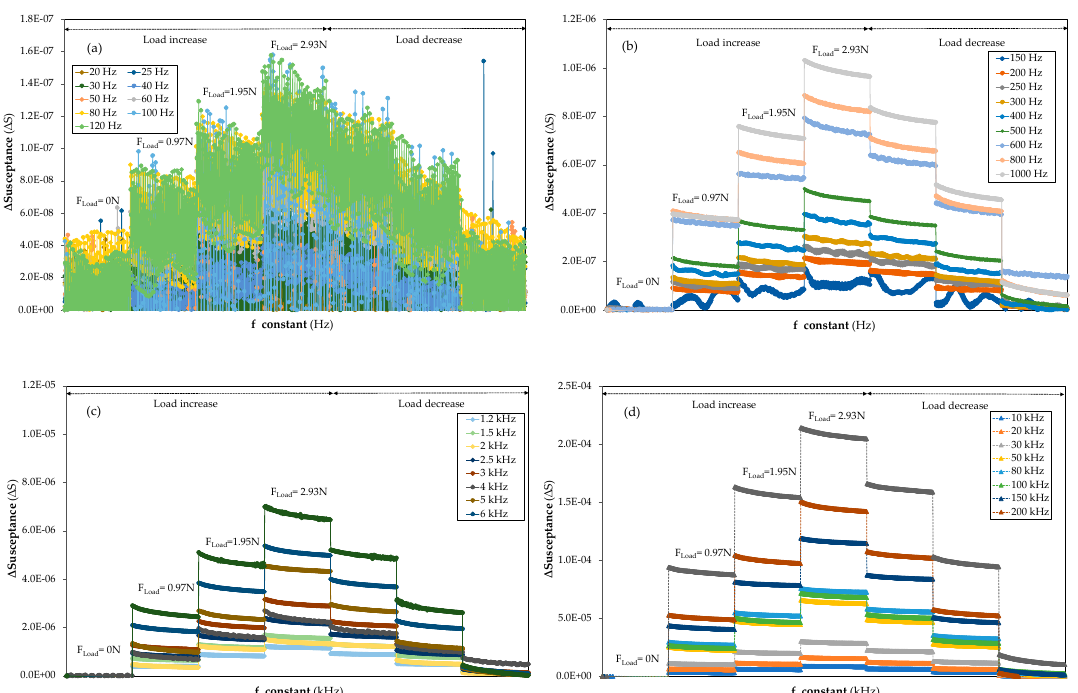
Figure 4. Loading and unloading e ff ect (from F = 0N to 3N) on ∆ S measured on the time domain signal at a constant frequency for a smart structure manufactured in 3 mm thick aluminium: ( a ) frequencies range from 20 to 120 Hz, ( b ) frequencies range from 150 Hz to 1 kHz, ( c ) frequencies range from 1.2 to 8 kHz and ( d ) frequencies range from 10 to 300 kHz. those at lower frequencies in Figure 4a − c.